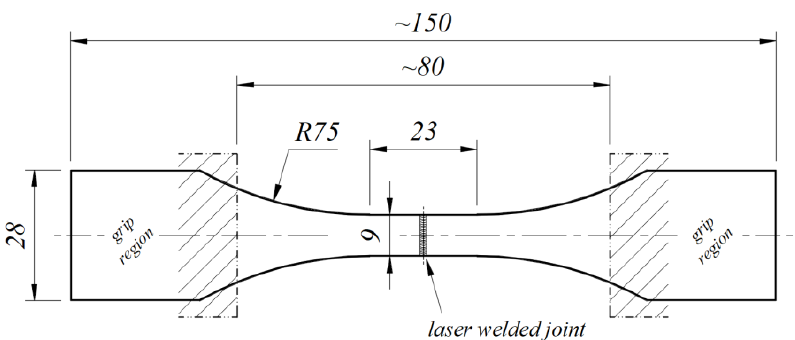
Figure 1. Geometry of the fatigue test specimens (all dimensions in mm) with fixture spam and grip regions according to ISO 6892-1.